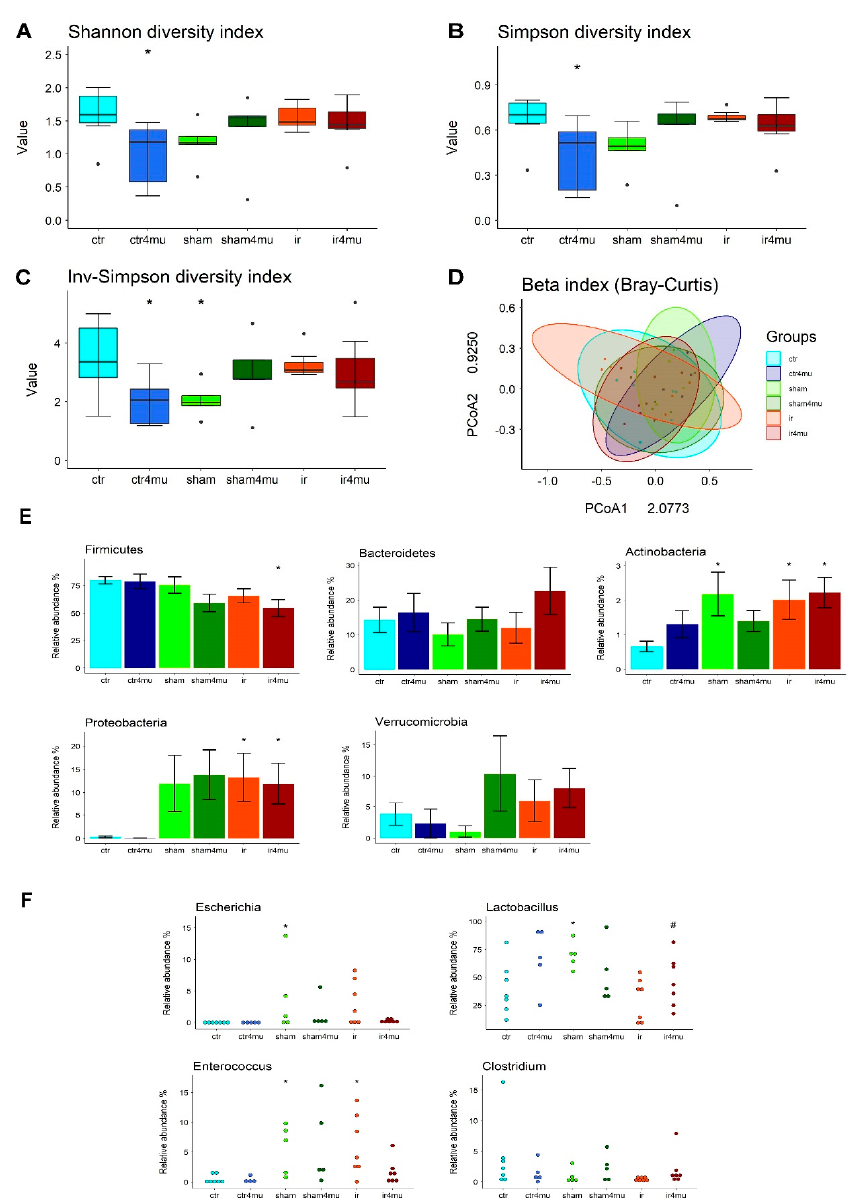
Figure 7. 4—MU treatment alters the composition of bacterial gut microbiome after IRI injury. ( A – C ) Estimation of microbial community α -diversity by Shannon, Simpson and inverse-Simpson in- dexes. Black dots represent the outliers. * p < 0.05, vs control group by ANOVA with Duncan post hoc test. ( D ) Principal Coordinates Analysis (PCoA) plot illustrating gut microbiome β -diversity calculated using the Bray–Curtis dissimilarity. After analysis of similarities (ANOSIM), no signifi- cant differences were observed among the different experimental groups. Values are expressed as mean ± SEM. * p < 0.05 by ANOVA with Duncan’s post hoc test with respect to non-injured. ( E ) Relative abundance, expressed as percentage of total sequences of selected phylum and genus ( F ),